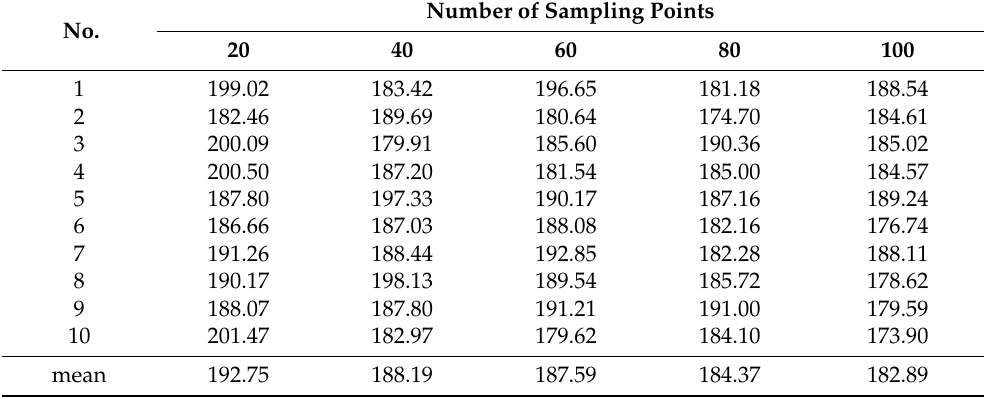
Table 3. Path distance using PRM.